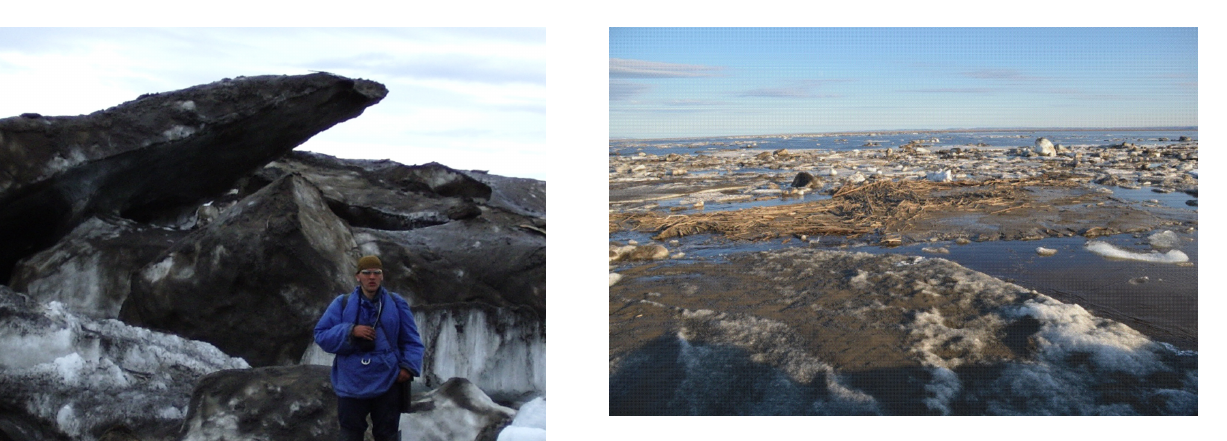
Figure 11. River ice during a flood on the Olenekskaya branch (photo by M.